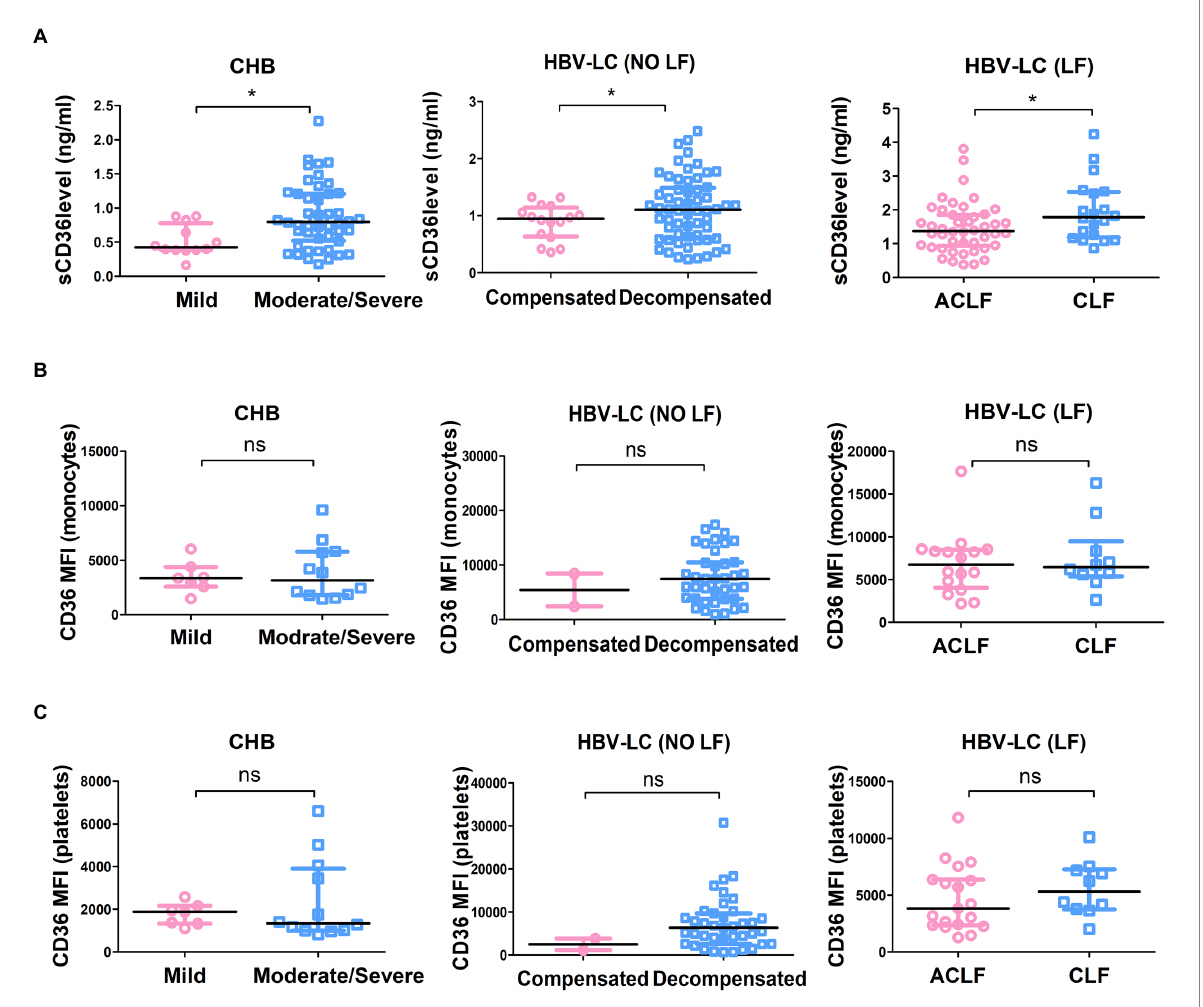
FIGURE 2 Correlation analysis between plasma CD36 and the severity of HBV-related liver diseases. CHB patients were divided into mild group and moderate-to-severe group, HBV-LC (NO LF) patients were divided into compensated group and decompensated group, and HBV-LC (LF) patients were divided into acute-on-chronic liver failure (ACLF) group and chronic liver failure (CLF) group. (A) Plasma sCD36 levels, (B) the expression of CD36 on monocytes, and (C) platelets in the above groups. * p < 0.05 as determined by Man - Whitney U test for non-parametric data or t test for parametric data. * p < 0.05, ns, no statistical